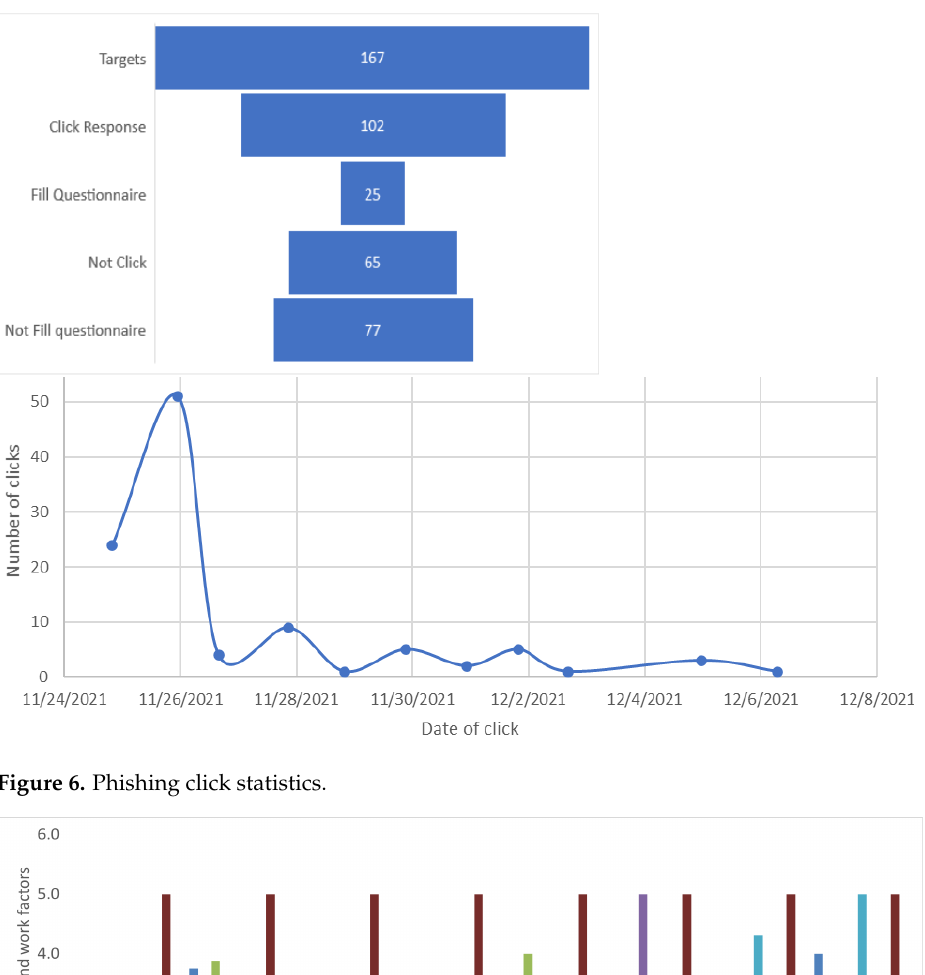
Figure 6. Phishing click statistics.